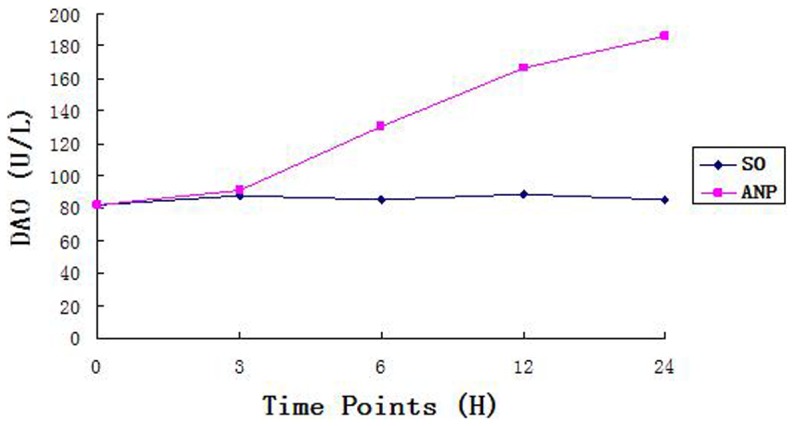
Induction of DAO. Described the variation tendency of DAO in two groups.